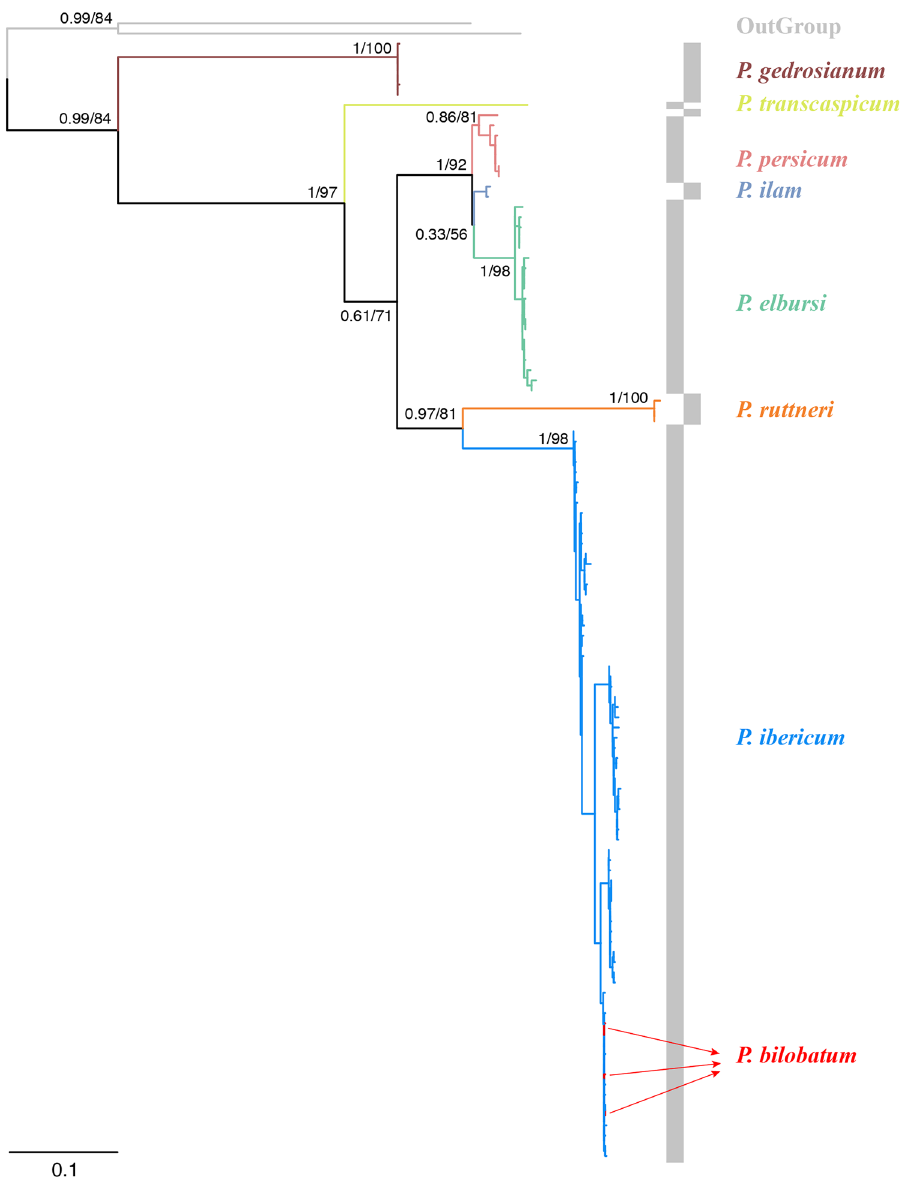
Figure 2. Tree based on the mitochondrial barcode region of Iranian freshwater crabs. Values on nodes represent a-bayes values/bootstrap. The list of taxa is available in Supplementary Table 1. The colours used for each species correspond to the same colours used in Fig. 1.